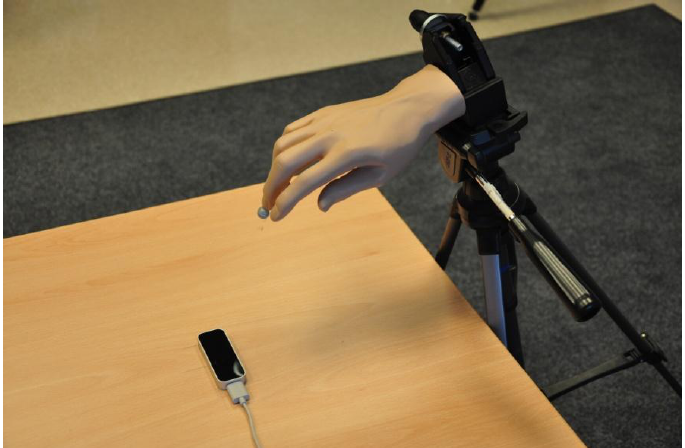
Figure 3. To improve the tracking capabilities of the Leap Motion Controller, the marker was placed at the tip of the index finger of a plastic arm model. During the measurement of static locations, the arm was fixed in place using a